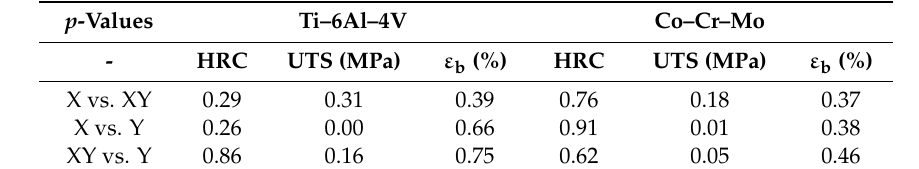
Table 6. Values resulting from the t -test for the variables HRC, UTS, ε b among the groups built in different orientations. Records below the level of significance of 0.05 are bold.